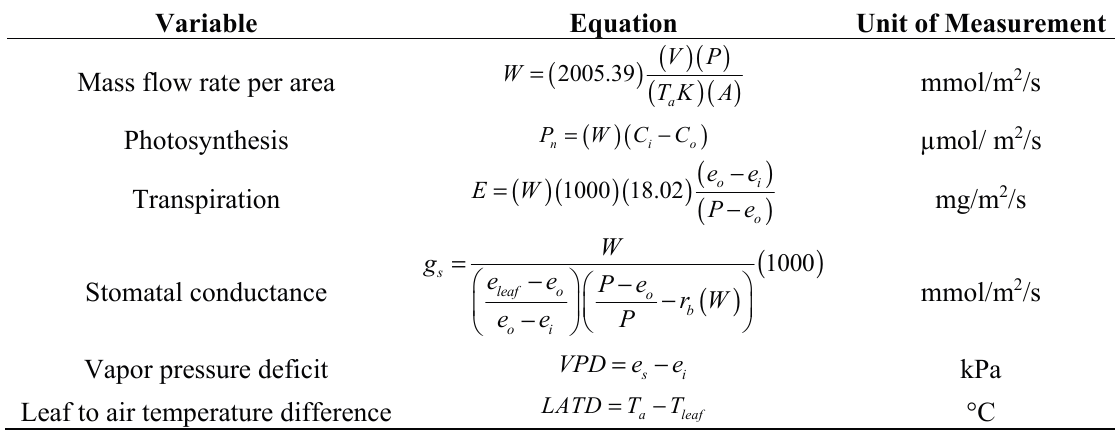
Table 1. Equations for the estimation of physiological processes of